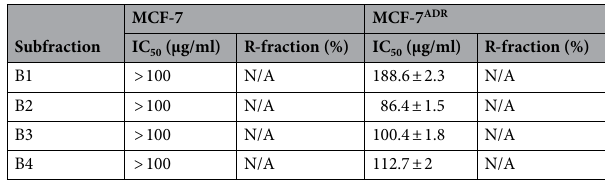
Table 4. Cytotoxic effect of subfractions (B1–B4) of Fr-3 within MCF-7 and MCF7- ADR cell lines. # N/A means not applicable.